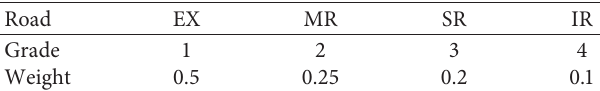
Table 2: Grades and weights of the urban roads in the study